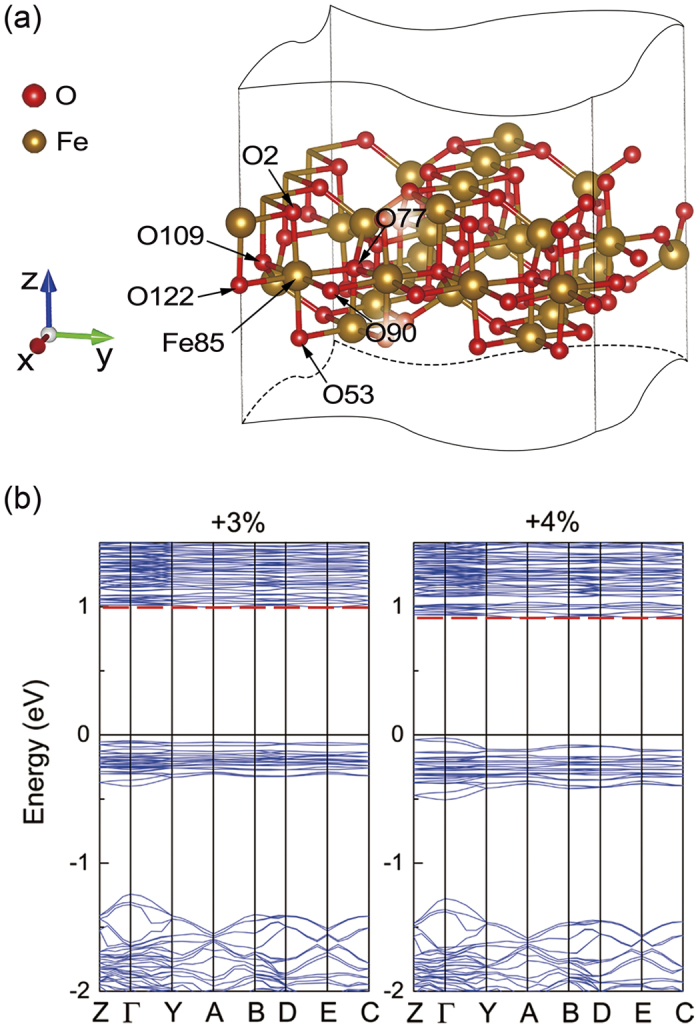
(a) The local structure of Fe(B42) under Cc symmetry. (b) The band structure under Cc symmetry with +3% and +4% compressive strain in left and right panel, respectively.